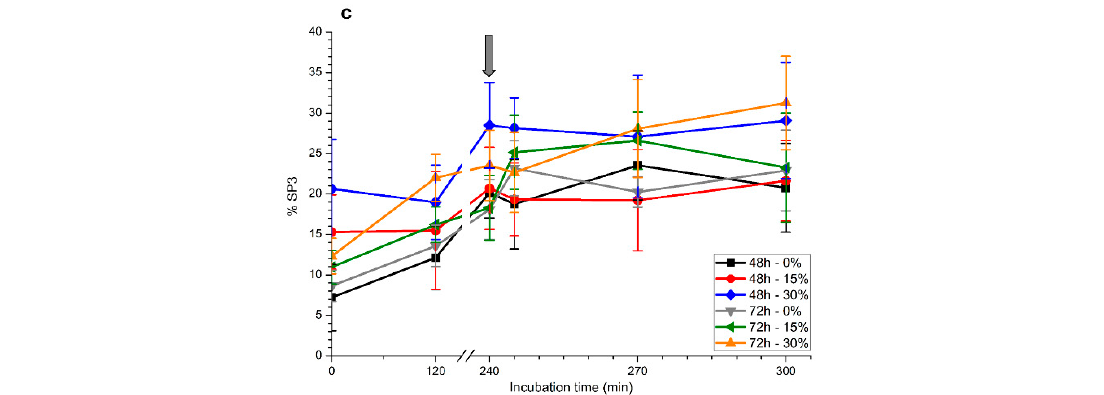
Figure 2. Percentages of motile sperm populations (( a ) SP1, (b ) SP2, and ( c ) SP3) during in vitro capacitation and progesterone-induced acrosomal exocytosis after previous storage of spermatozoa at 17 °C with different concentrations of seminal plasma (0%, 15%, and 30%) for 48 h or 72 h. Grey arrow indicates the time at which 10 μ g/mL progesterone was added to induce acrosomal exocytosis (i.e., 240 min). Different letters mean significant ( p < 0.05) differences between treatments at a given time point. Data are shown as mean ± SEM for seven independent experiments.